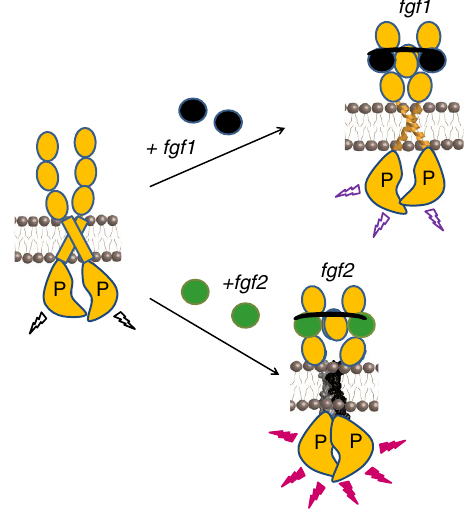
Figure 8 | The mechanism of FGFR3 activation. Top: on fgf1 binding to extracellular domains D2 and D3, and the D2–D3 linker 26,69 , FGFR3 TM domains change their configuration and engage in interactions that involve small residues in the N-terminal portion of the TM domains. FGFR3 dimer phosphorylation increases by a factor of B 1.5 to B 3. Bottom: binding of fgf2 to D2, D3, and the linker, on the other hand, triggers a switch towards a closely packed TM dimer structure. Contacts between the TM helices are likely mediated by L377, G380 and/or A391, as in the case of a published NMR structure of the isolated TM domain 46 . FGFR3 dimer phosphorylation increases by a factor of B 2 to B The EC þ TM (A374I-G375I-S378I) FGFR3 mutant and the EC þ TM (L377I-G380I-A391I) FGFR3 mutant used in the FRET studies were generated from the full-length mutants. The complementary DNA (cDNA) encoding the EC and mutant TM domains was amplified using PCR and was double digested with HindIII and EcoRV. The FGFR2 EC þ TM-(GGS) 5 -YFP and FGFR2 EC þ TM-(GGS) 5 -mCherry plasmid constructs were also double digested with HindIII and EcoRV enzymes, and ligated with the PCR products. Details on the cloning of FGFR3 TM-(GGS) 5 -YFP and FGFR3 TM-(GGS) 5 - mCherry into the pcDNA3.1( þ ) vector are given elsewhere 40 . For this work, the sequences encoding for the TM domains of FGFR1 and FGFR2 were amplified by PCR, double digested using KpnI and EcoRV restriction enzymes and ligated with pcDNA-(GGS) 5 -mCherry and pcDNA-(GGS) 5 -YFP vectors to yield the FGFR1